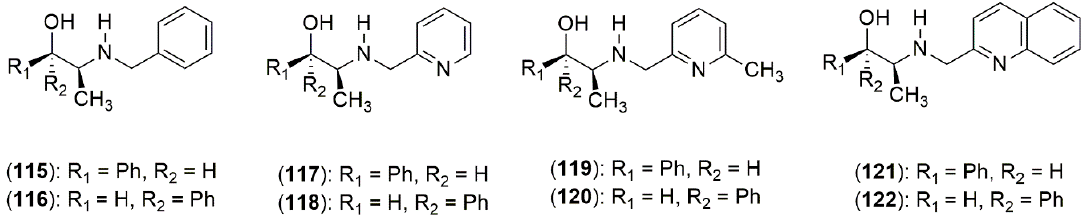
Figure 6. Ephedra Ligand Synthesis.